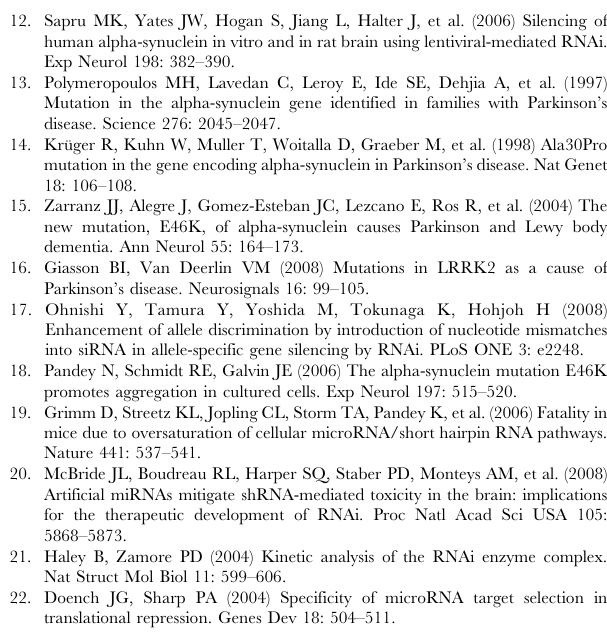
Figure S1 Cell counting and cell viability from cells expressing eGFP-tagged a -synuclein targets. A) Cell counts from HEK-293 cells transfected with stated eGFP-tagged a -synuclein targets or mock transfection at 48 hrs post-transfec-